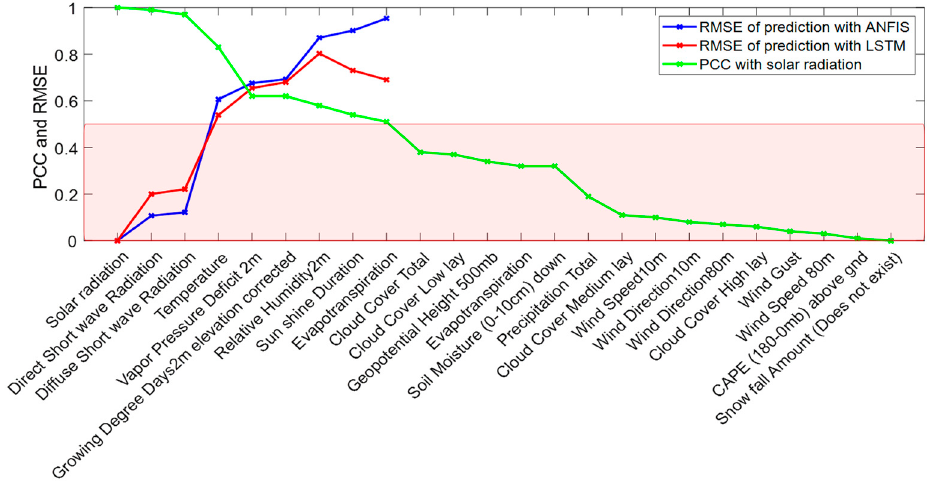
Figure 10. Autumn season ranking between different meteorological parameters based on Pearson Correlation Coefficients and comparative performance of LSTM and ANFIS models with parameters selection (PCC ≥ 0.5) (employed dataset from 21 September to 20 December 2020).